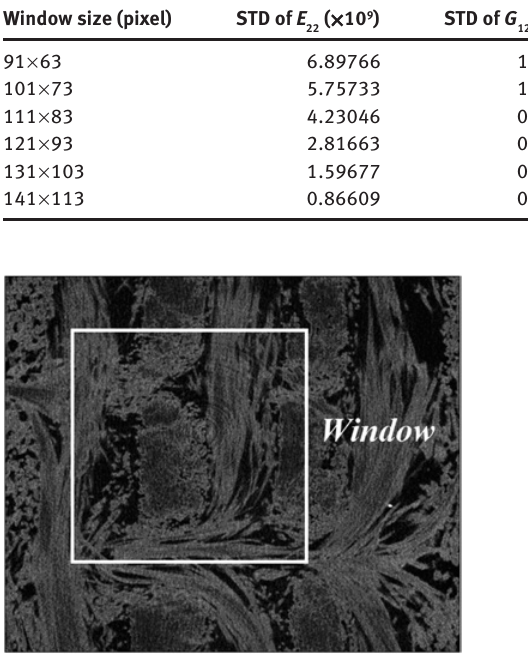
Figure 11: Window moving randomly in slices.